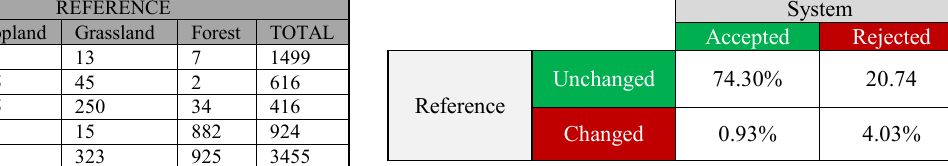
Table 5: Confusion matrix for the grassland